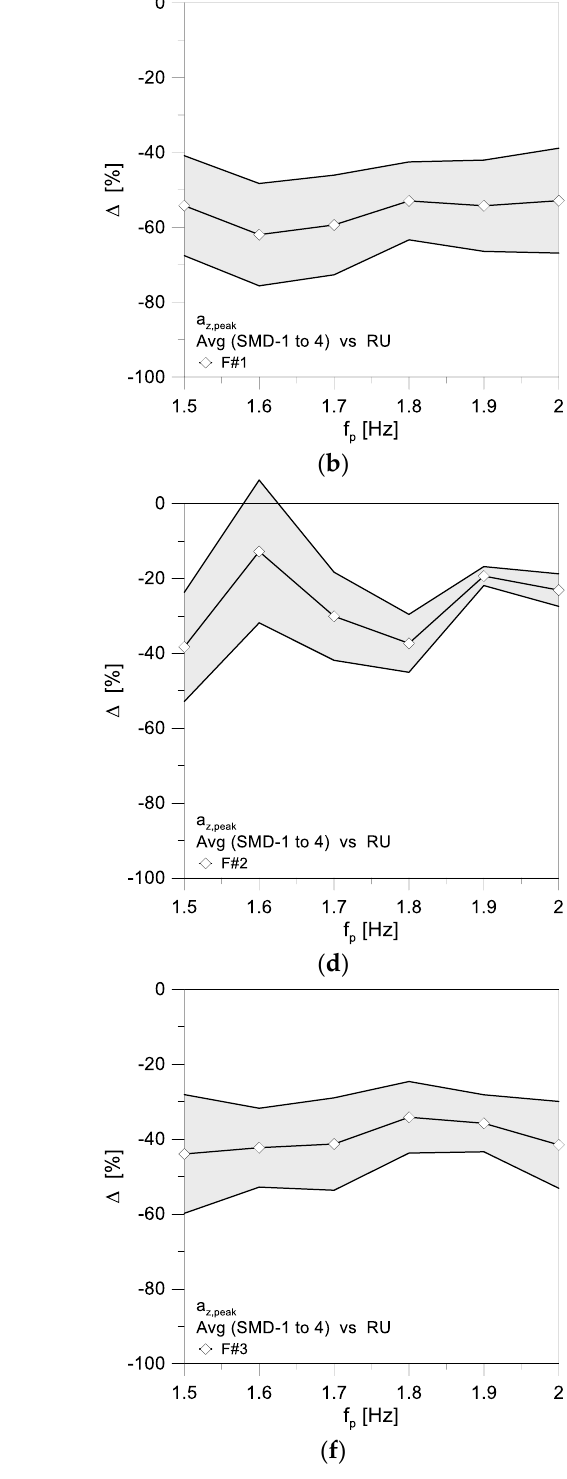
Figure 9. Numerical results for ( a , c , e ) RMS acceleration and ( b , d , f ) peak acceleration for F#1, F#2 and F#3 systems, in terms of SMD (average ± standard deviation) to RU percentage scatter, as a function of walking frequency f p (ABAQUS).